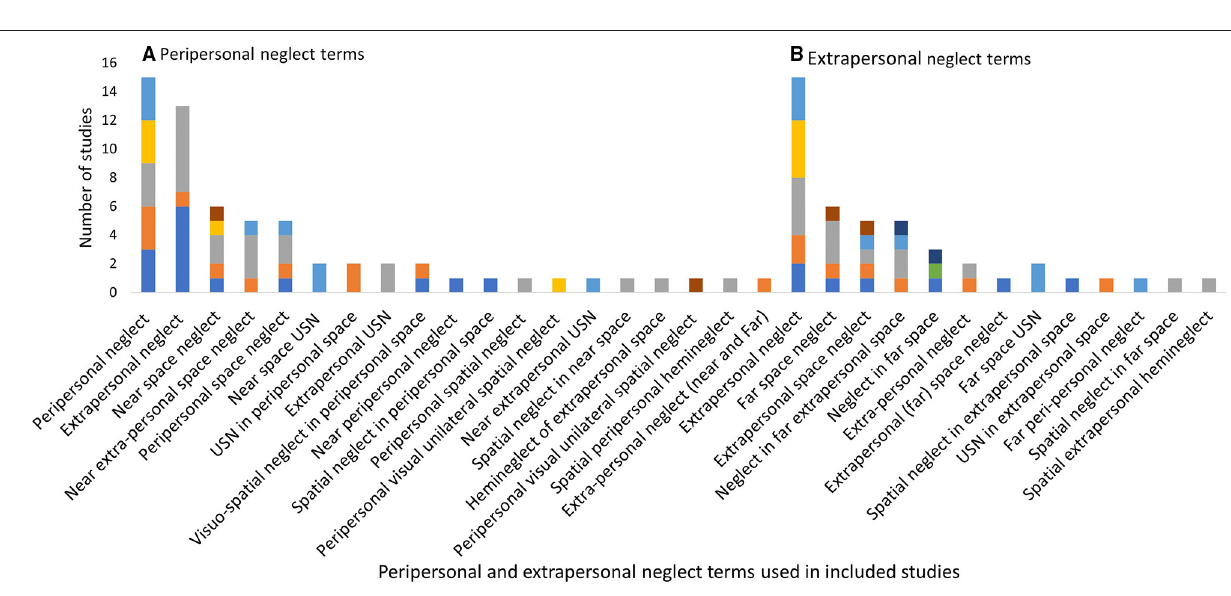
FIGURE 7 | Peripersonal and extrapersonal neglect terms used within the included studies. (A) Peripersonal and (B)